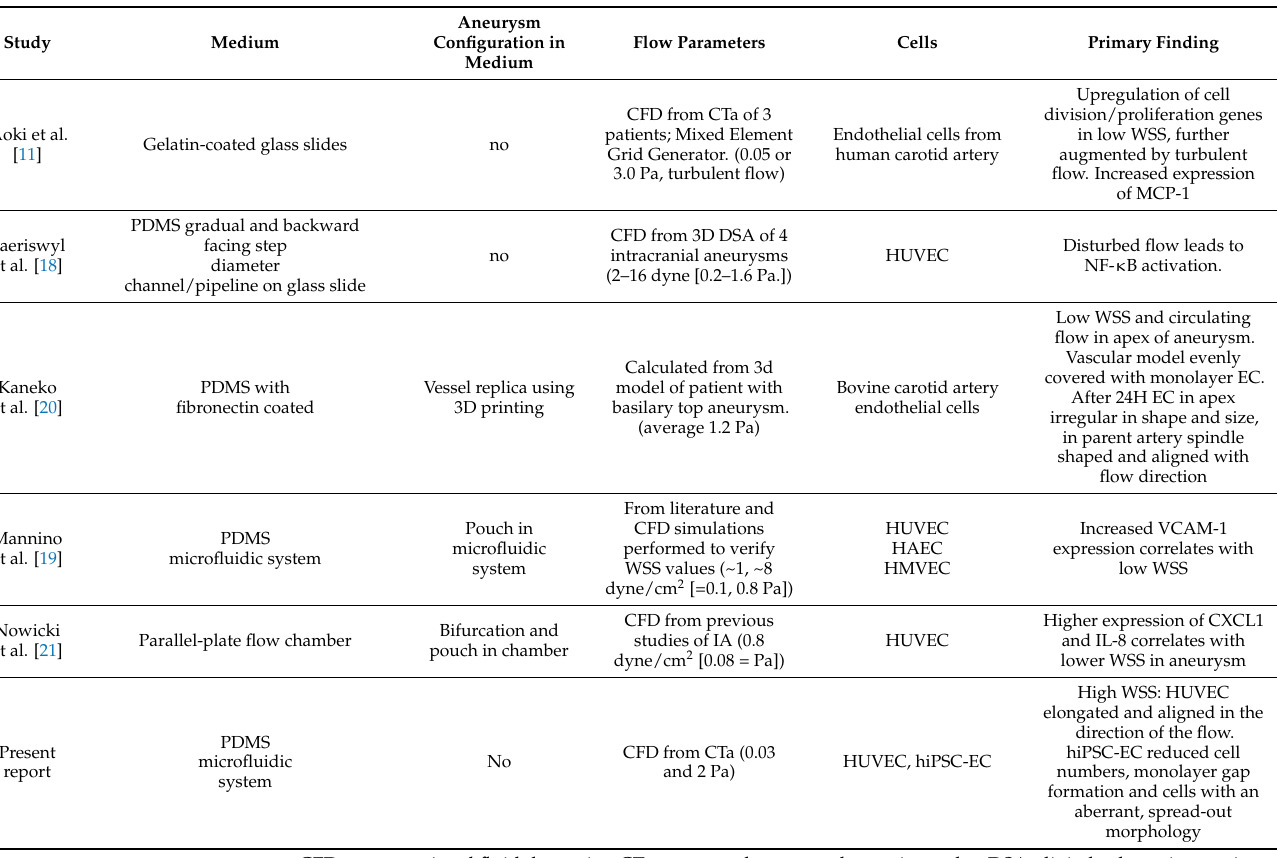
Table 1. Overview of proposed in vitro aneurysm